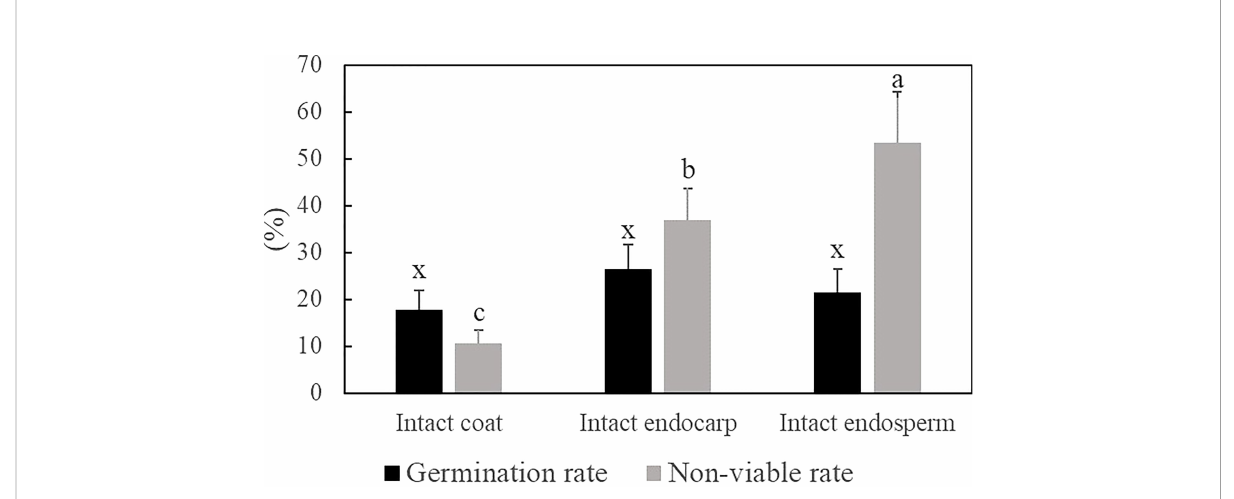
FIGURE 5 The germination rate and non-viable rate of three types H. ovalis seeds after culturing in red light, 30 psu salinity and 30°C for 1 month (n=12). The black column represents the germination rate and the gray column represents the non-viable rate (mean ± SE). Different letters a, b, and c indicate signi fi cant differences among H. ovalis seed types in non-viable rate. And x represents no signi fi cant differences among these seed types in germination rate. The data were analyzed using one-way